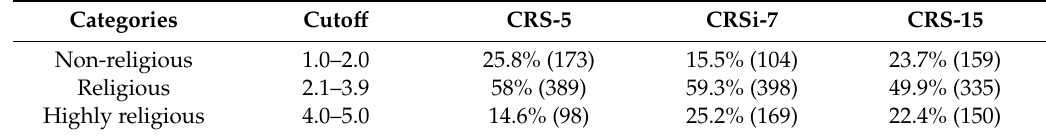
Table A5. Categorization by CRS-5, CRSi-7, and CRS-15.